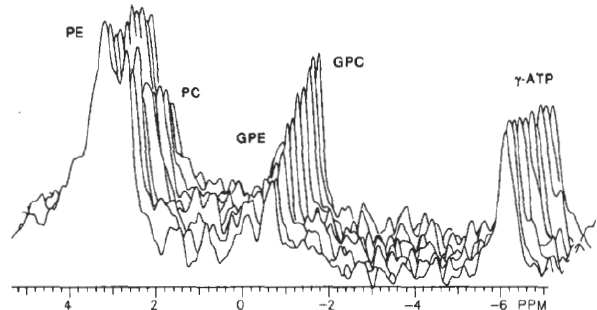
Figure 11. Effect of HC-3 in the perfusate. Quantitative 31P NMR spectra are depicted of cells grown in IMEM with 15 mM choline and 10 mM ethanolamine, harvested at log phase, and then per- fused with Buffer A, 11 mM glucose, plus 100 mM HC-3. Each spectrum represents a 1-h accumulation.